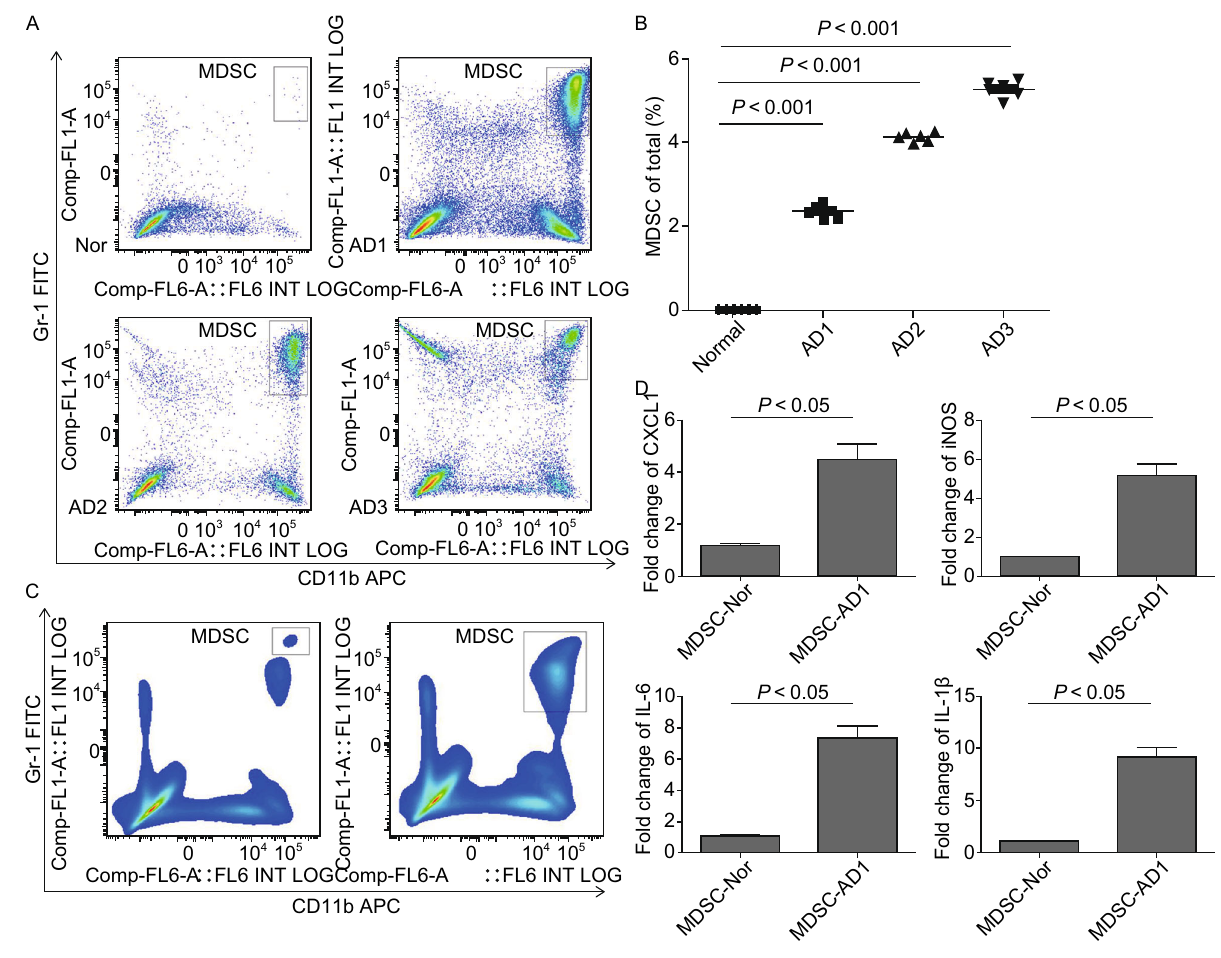
Figure 3. In fi ltration of MDSCs into the colonic tissues and its pro-in fl ammatory properities. (A) Flow cytometry dot plot gating for MDSCs (CD11b + Gr-1 + ) in fi ltration into colon tissues along the disease development. The results represent 3 independent experiments ( n = 4). (B) Statistical analysis of in fi ltrated MDSCs in the colonic tissues of C57 normal and AD mice. The results represent 3 independent experiments ( n = 6). * represents P < 0.05; P values were obtained using two-tailed Student ’ s t tests. (C) Fluorescence-activated cell sorting of MDSCs in C57-AD mice colonic tissues and spleen of C57 mice. The left was sorted MDSCs from spleen of C57 mice and the right was sorted MDSCs from colonic tissues of C57-AD mice. (D) Total RNA from MDSCs sorted from C57 normal and C57-AD mice were analyzed by real-time RT-PCR for the expression of pro-in fl ammatory cytokines. Results are given as fold increase over the mRNA level normalized to β -actin and are representative of at least 3 different experiments; shown are mean ± SD from triplicate